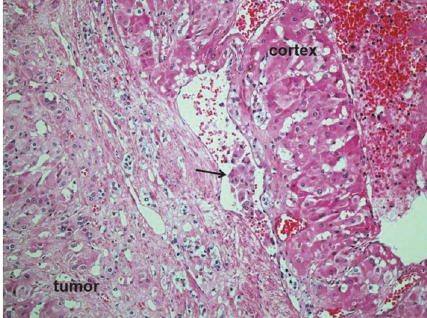
Figure 4: Tumor, vascular invasion at tumor edge, and hyperplastic cortex. The arrow represents vascular invasion of the